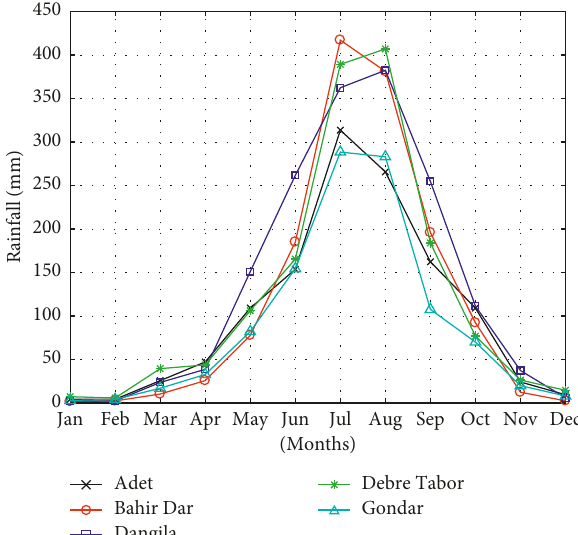
Figure 2: Mean monthly amount of rainfall for the selected stations averaged over the period 1979–2015.